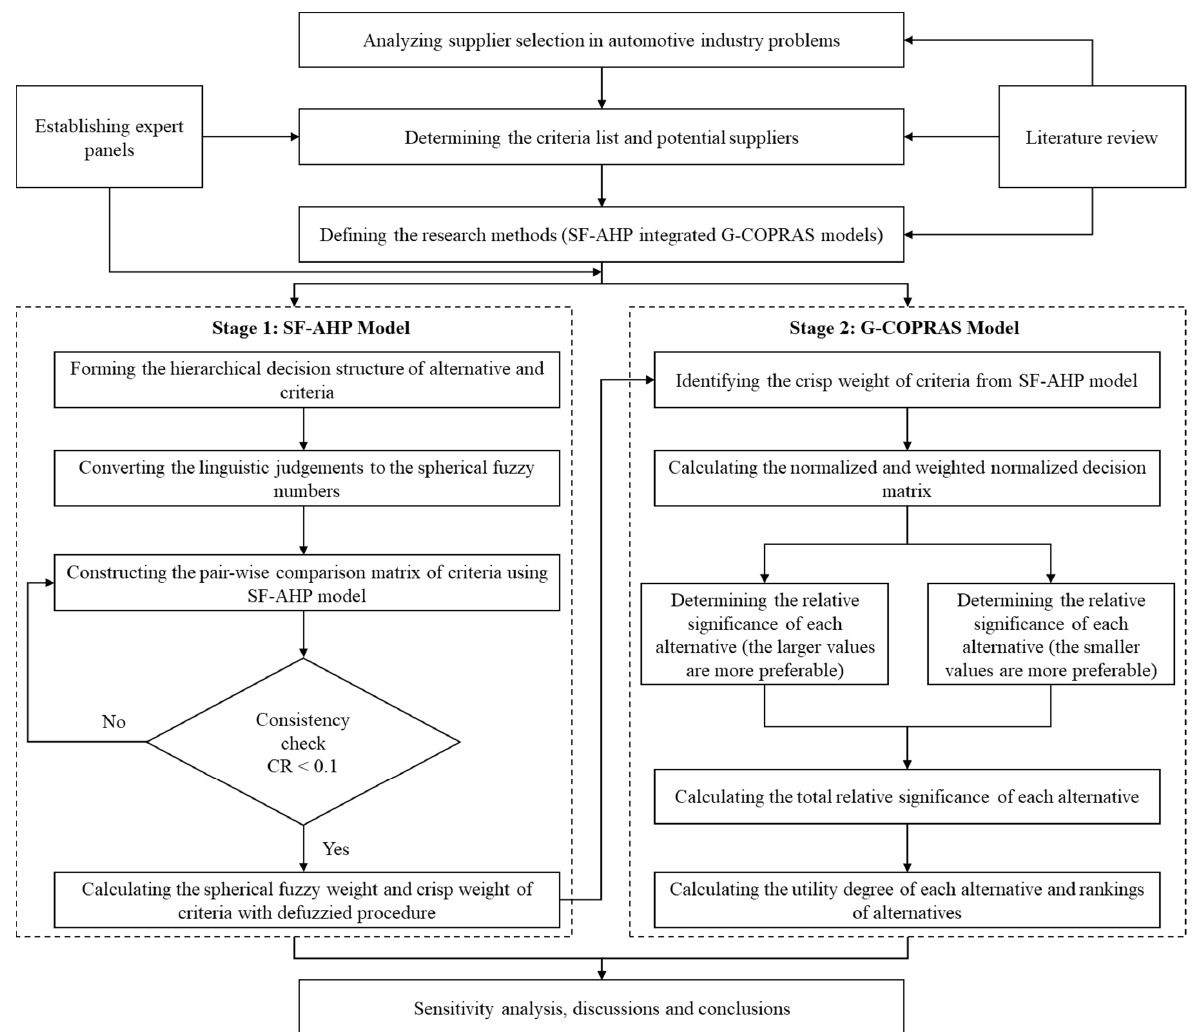
Figure 1. The proposed MCDM